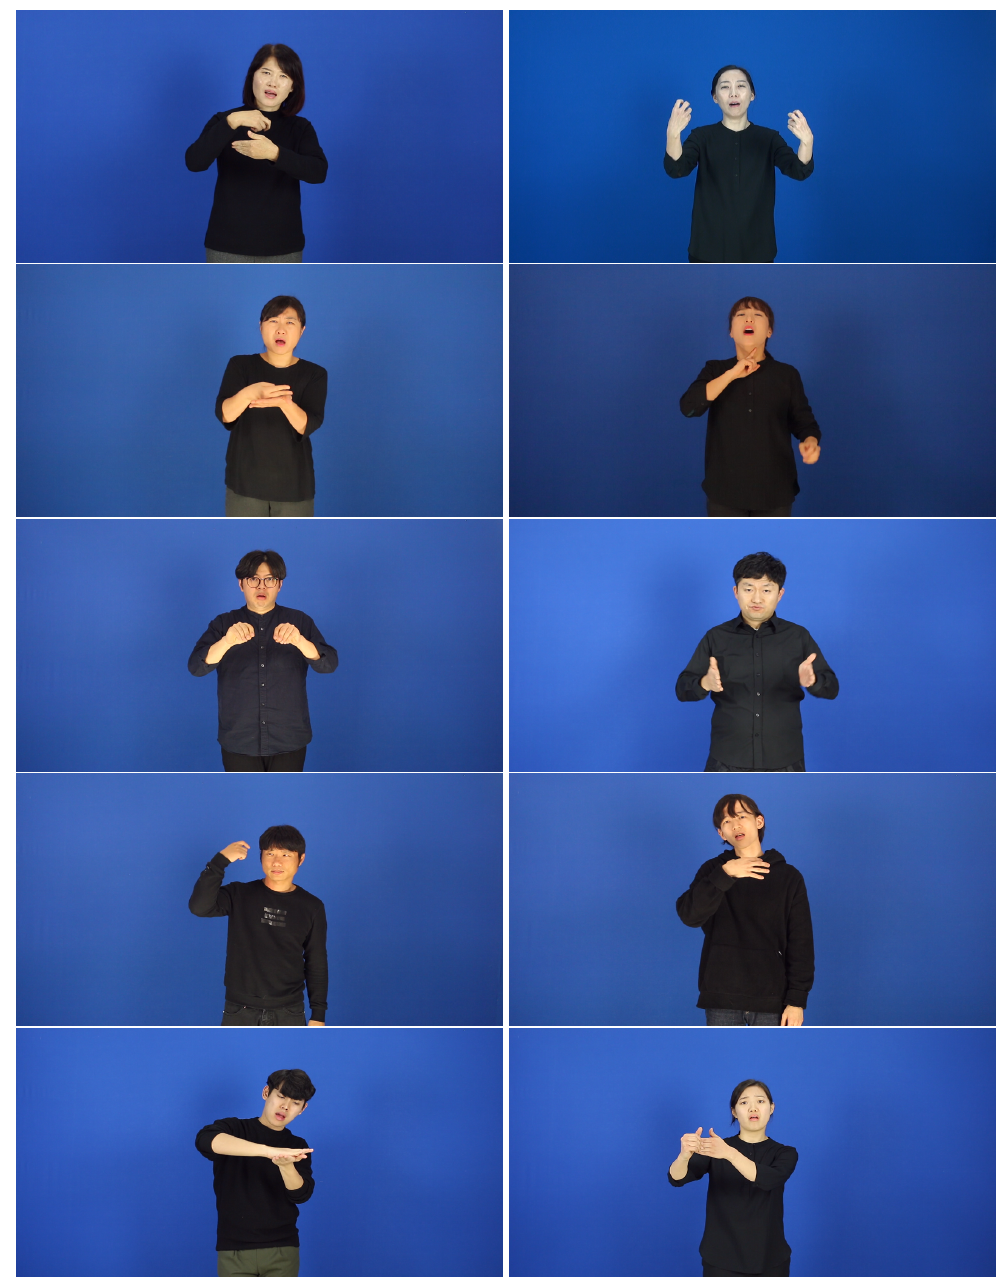
Figure 2. Ten example frames from from our sign language dataset. Each frame was extracted from a sign video of a distinct